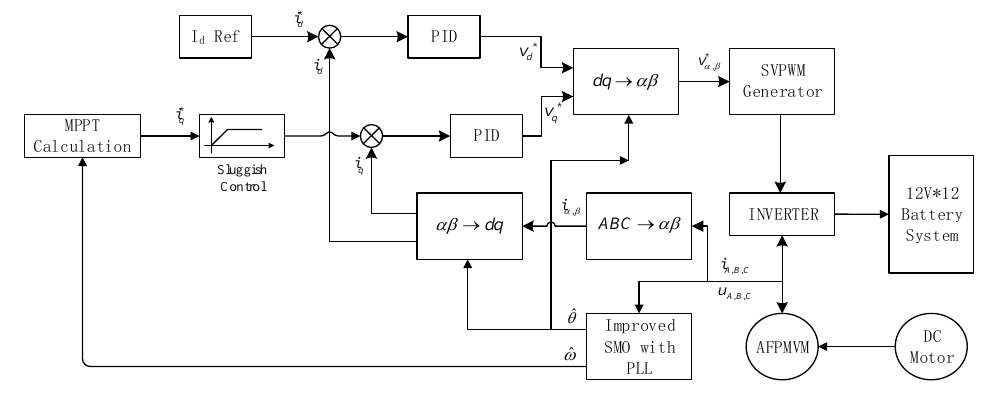
Figure 10. Experiment flow chart.